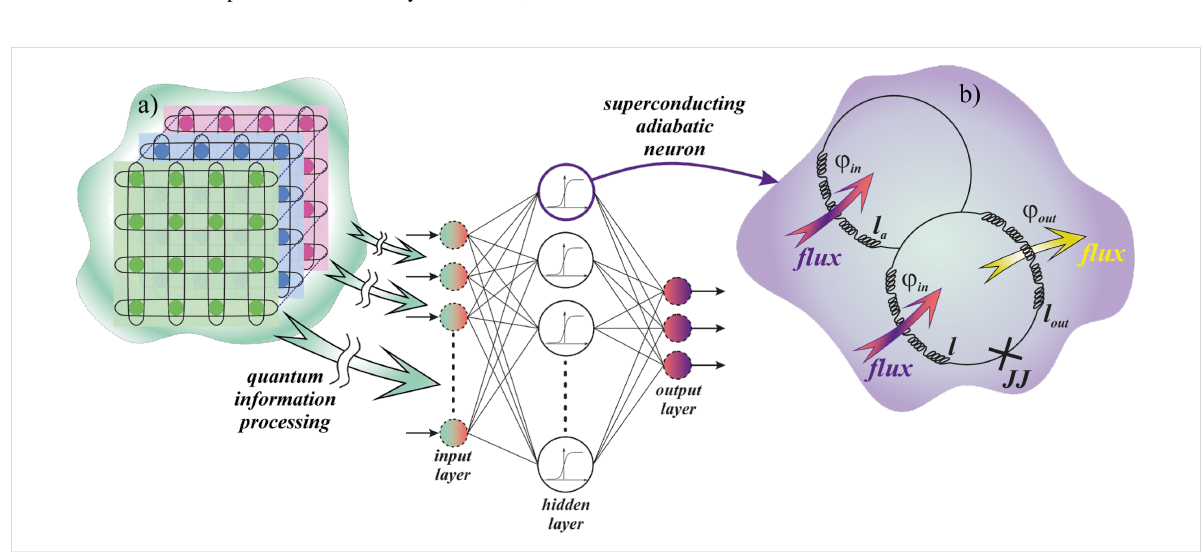
Figure 1: (a) Sketch of a flexible hybrid system consisting of a classical ANN having its configuration (synaptic weights) dynamically adjusted by a quantum co-processor. (b) Schematic representation of the S Q neuron providing nonlinear magnetic flux transformation.